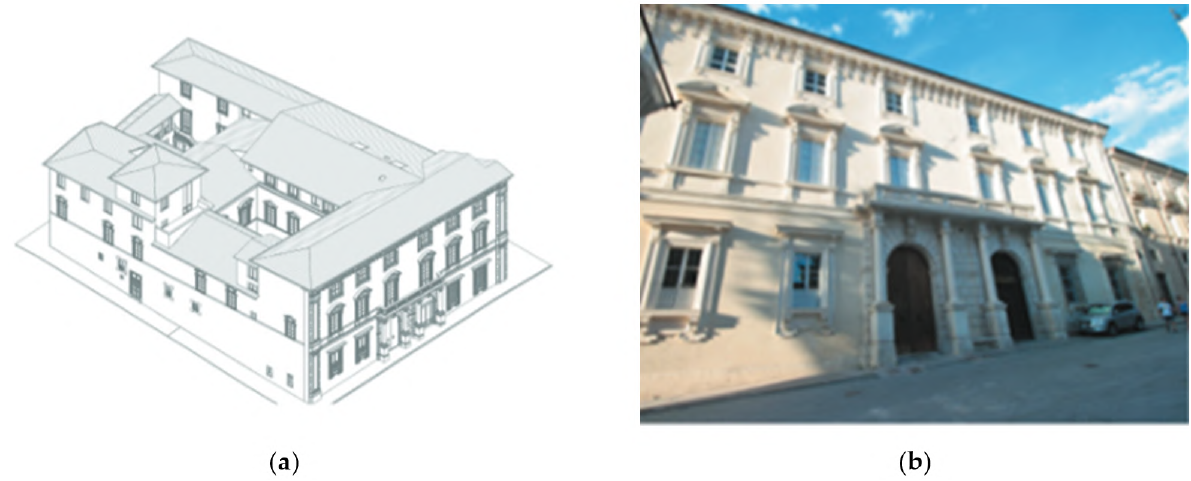
Figure 4. ( a ) A 3D view of Pica Alfieri’s Palace; ( b ) photo of the façade [27]. Due to the reasons above, the attempt to classify and organize the results of seismic ble. Each building expresses a singularity, intrinsic geometries, variabilities, alternation of